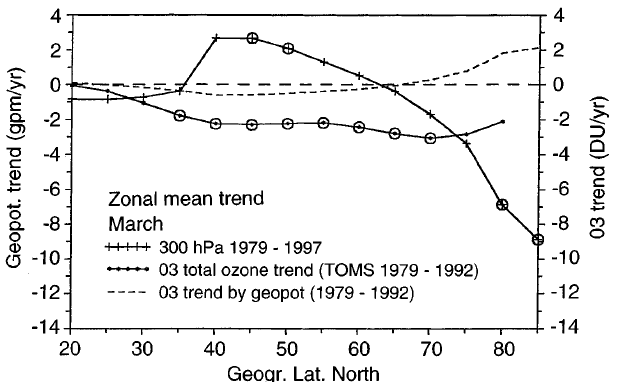
Fig. 8. Zonal symmetric trend values in latitudinal dependence of the Northern Hemisphere for geopotential (300 hPa, 1979–97) and for total ozone (TOMS, 1979–92). Encircled values are significant >95%. Dashed curve : dynamically induced part of the ozone trend under distinct assumptions, see